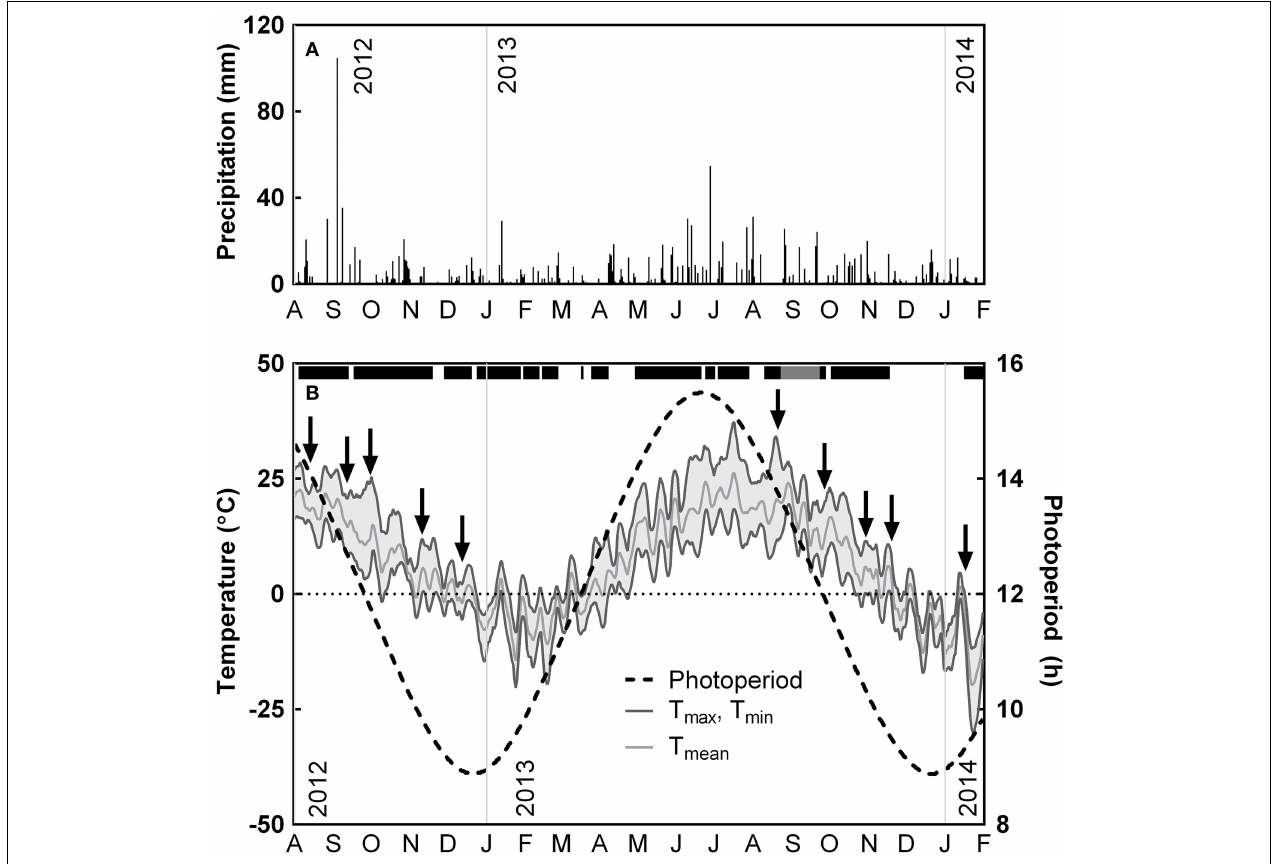
temperature (lower dark gray line), as well as photoperiod (dotted black line). Arrows indicate measuring dates. Black bar above temperature data indicates periods where heaters were operating; gray bar indicates period where heating was on, but data was lost due to a logger malfunction.